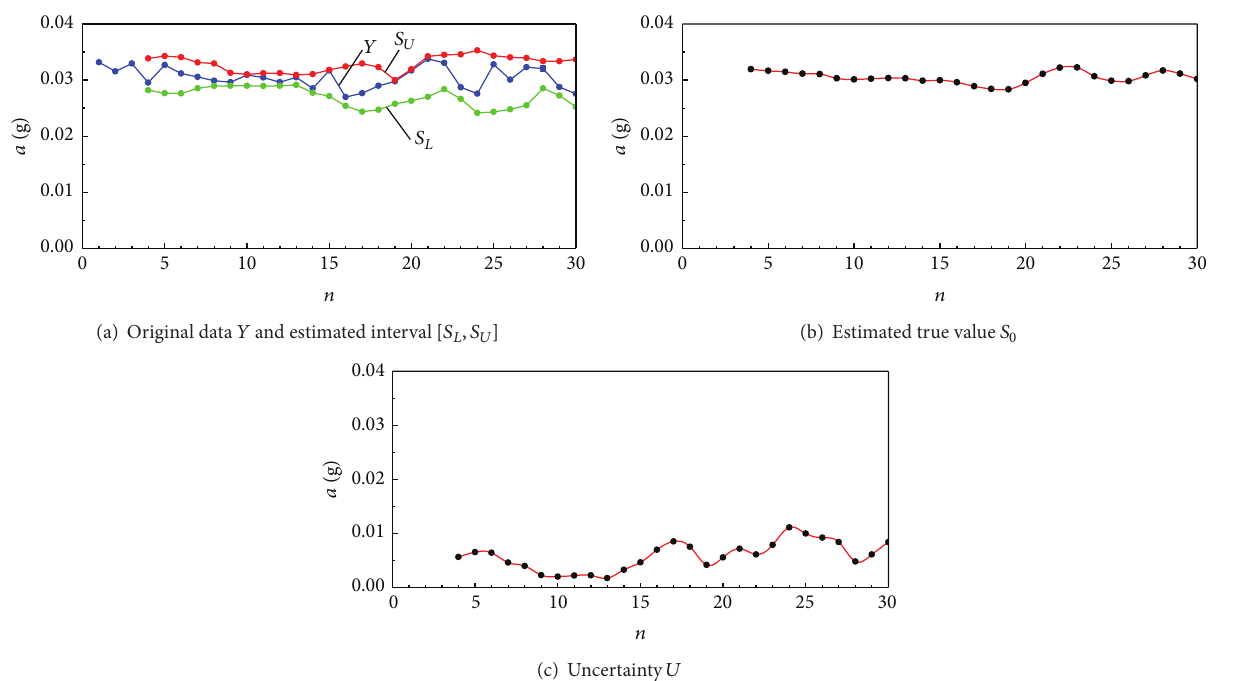
Figure 7: Dynamic evaluation for vibration acceleration of gearbox with no modification